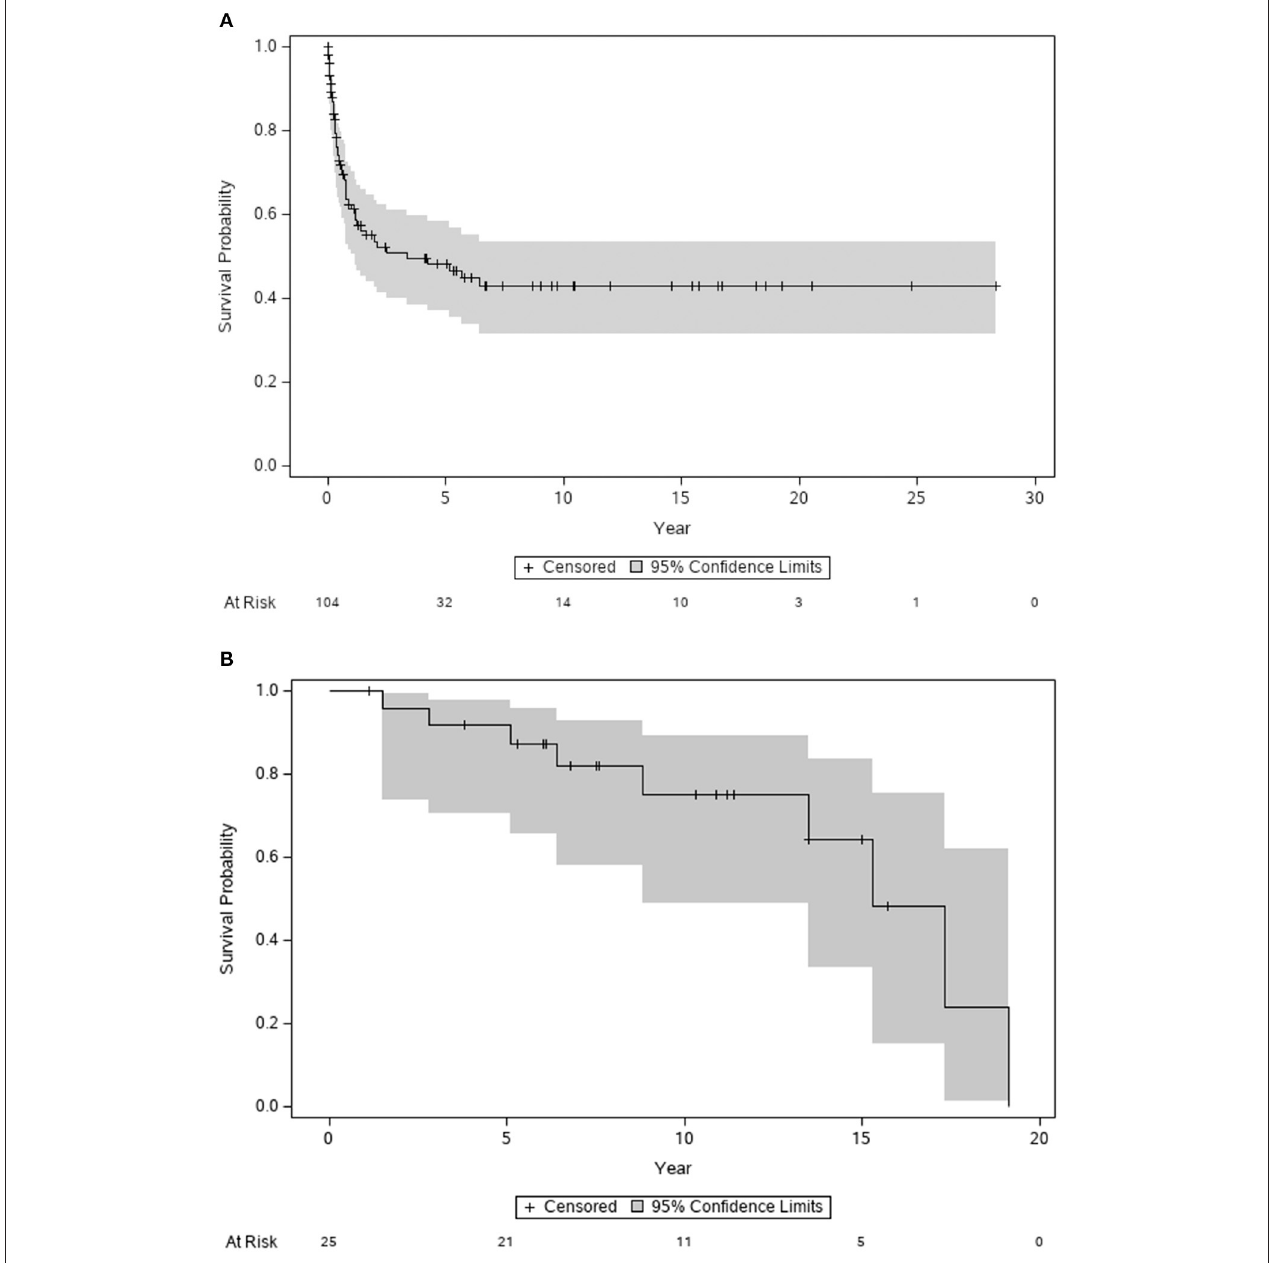
FIGURE 1 | Transplant-free survival (A) and post-transplant survival (B) for patients with primary dilated cardiomyopathy. Gray shaded, 95% confidence intervals. 4.8 ± 5.8 years, P < 0.001). No other significant differences were observed in clinical characteristics or